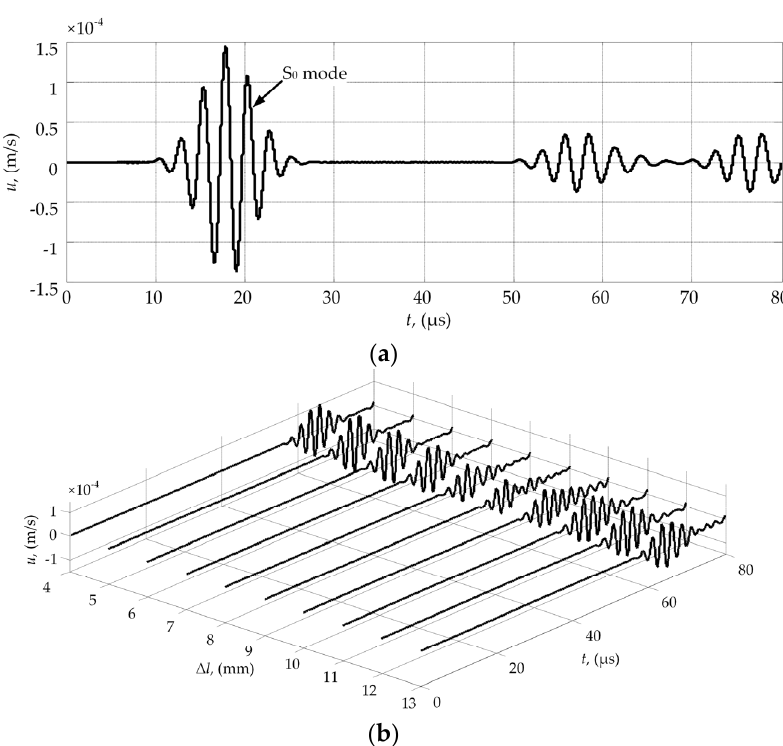
Figure 3. The waveforms of the signals measured: ( a ) before lap joint connection at Rc1 position; ( b ) after lap joint connection at Rc2 position in the case of different overlap zone width Δ l .